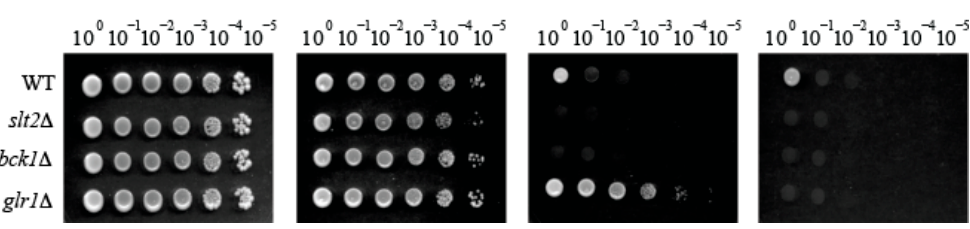
Figure 2. Yeast dilution bioassay showing differential susceptibility of S. cerevisiae slt2 Δ , bck1 Δ , and glr1 Δ mutants to cinnamic acid analogs (0.5 mM).